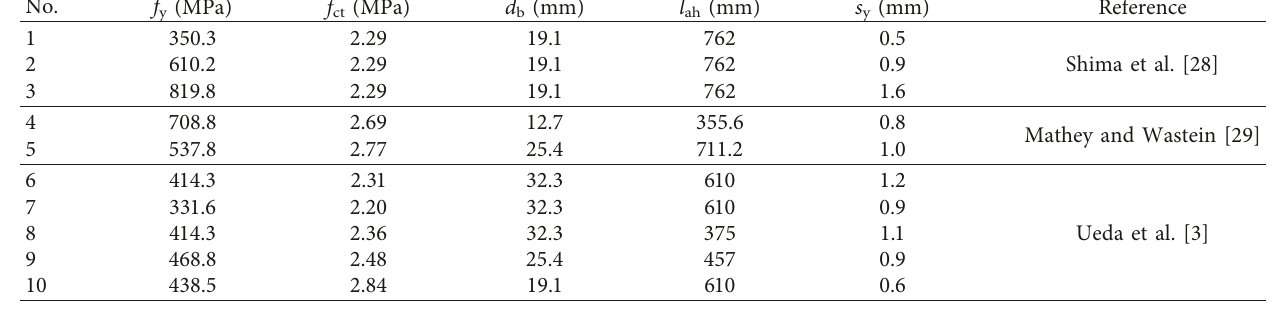
y and (b) s u . y in the literatures.